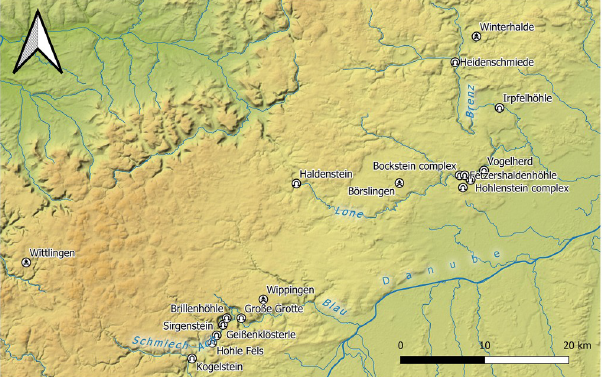
Fig 1. Map of Middle Paleolithic sites of the Swabian Jura discussed in the text. Legend: Caves/Abris and open-air sites are marked with a respective symbol. The site Heidenschmiede is in the upper right corner. Background map: C. Summer (ROCEEH), this work is distributed under CC-BY 4.0 license, see